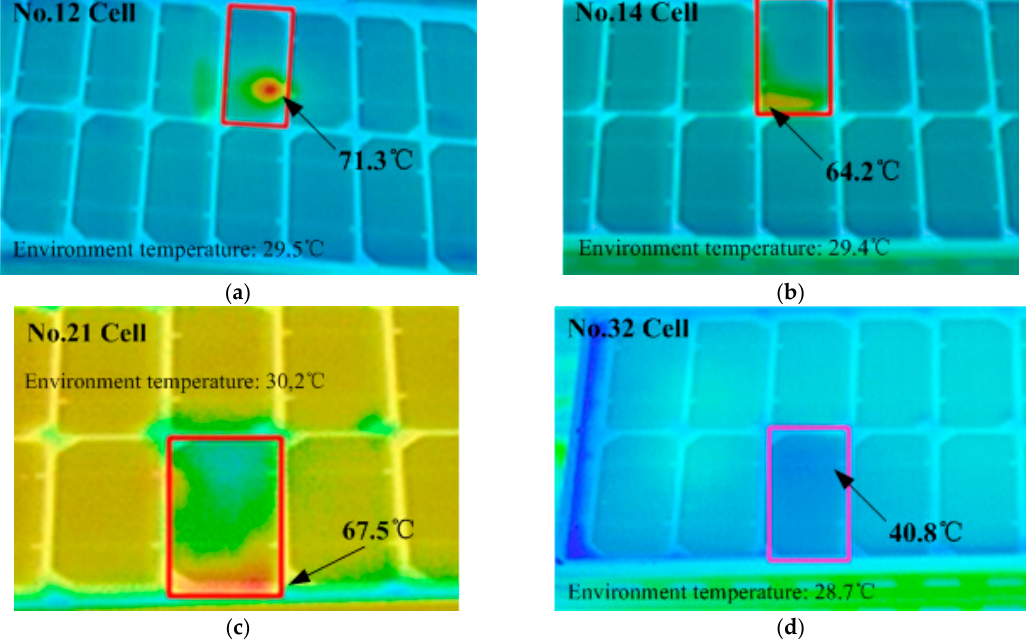
Figure 17. IR inspection results: ( a ) Hot-spot in No. 12 cell caused by micro-defects, the operating temperature at the hot-spot is 71.3 °C while the mean temperature of the rest cell is 38.7 °C, which represents a temperature difference of 32.6 °C; ( b ) Hot-spot in No. 14 cell; ( c ) Hot-spot in No. 21 cell; and ( d ) Thermal image of No. 32 cell, the temperature is 40.8 °C only raises 2–3 °C after 10 min of shading.